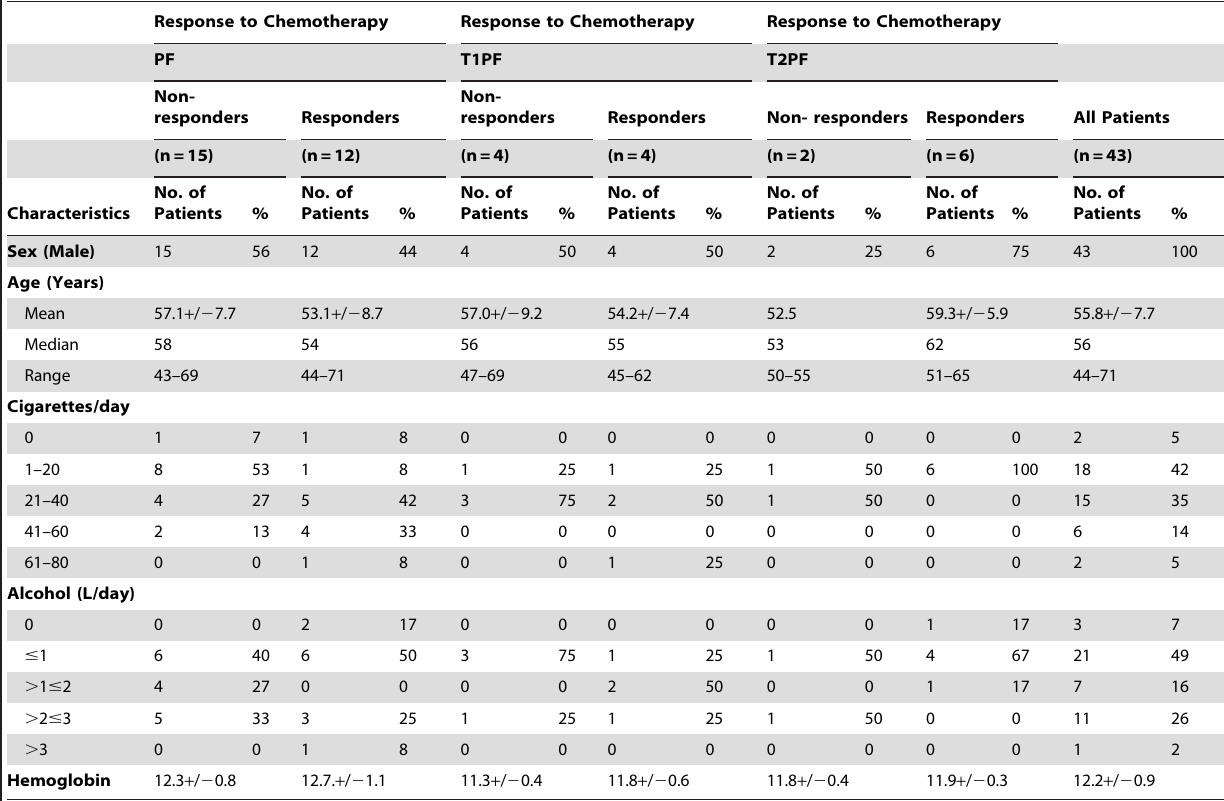
Table 3. Characteristics of Patients (TLDA